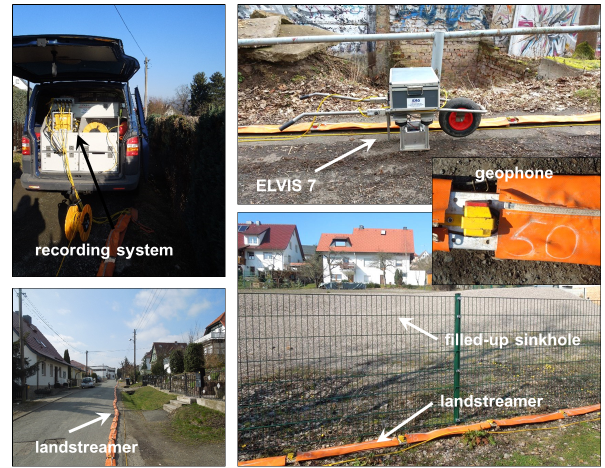
Figure 5. Photographs taken during the two field campaigns show- ing the micro-vibrator, the land streamer and the recording system used for the S H -wave reflection-seismic